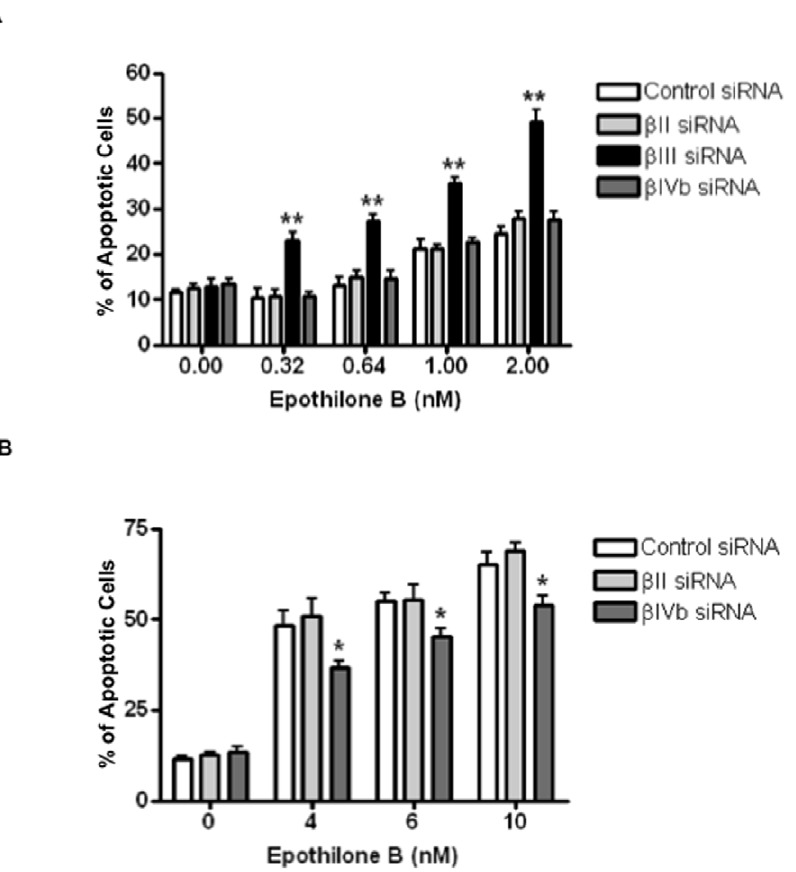
Figure 4. Annexin V staining of siRNA-transfected H460 cells following 48 h incubation with epothilone B. Open bars: control siRNA- transfected cells; light grey solid bars: b II-tubulin knockdown cells; solid black bars: b III-tubulin knockdown cells; dark grey solid bars: b IVb-tubulin knockdown cells. Note epothilone B was able to induce apoptosis in the b III-tubulin knockodown cells at concentrations as low as 0.32 pM (A), whereas higher concentrations of epothilone B induce significantly lower apoptosis in the b IVb-tubulin knockdown cells (B). Data represent means 6 SEM of at least three independent experiments. * P , 0.05; ** P , 0.01.